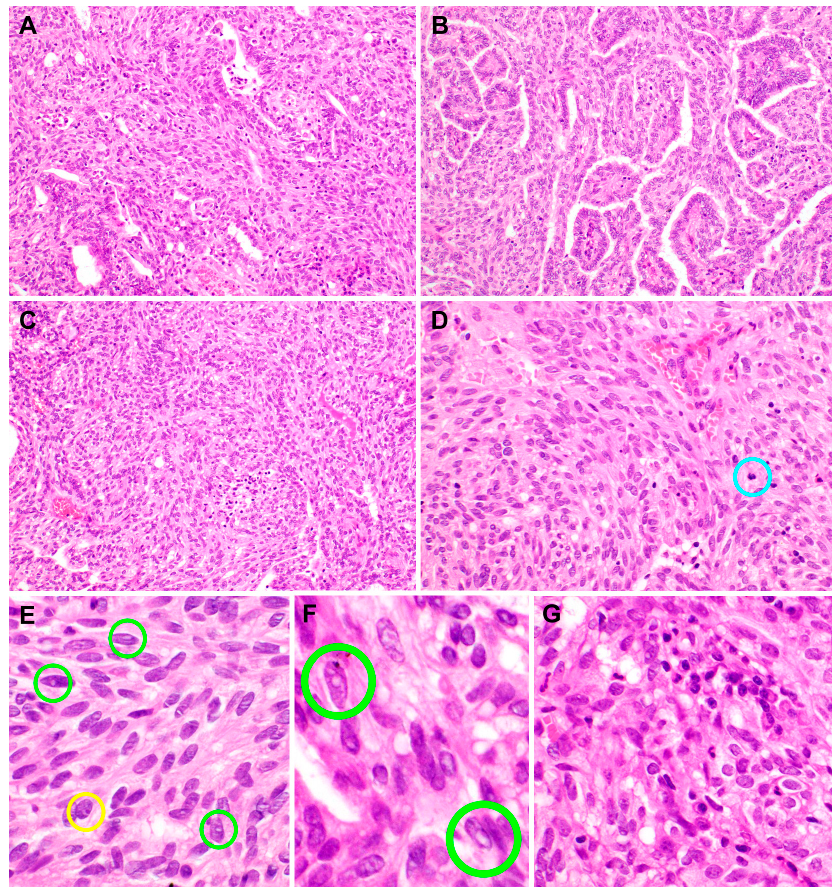
Figure 3. Histopathological features of the spindle cell component of the biphasic thyroid-like low-grade nasopharyngeal papillary adenocarcinoma. ( A ) Anastomosing nests and sheets of tumor cells with spindle-shaped nuclei were intermingled with the papillary component. ( B ) The papillary and spindle cell components merged imperceptibly. ( C ) In some areas, a transition from cuboidal-to-columnar tumor cells to spindle cells was observed. ( D ) Spindle cells were arranged predominantly in a stratified and whorling pattern. The blue circle indicates a mitotic figure. ( E ) Spindle cell nuclei were more elongated and hyperchromatic than the nuclei of epithelial cells covering the papillae. Small intranuclear pseudoinclusions (green circles), prominent nucleoli touching the nuclear membrane (yellow circle), and irregular nuclear membranes were observed. ( F ) High-power magnification view of the nuclear morphology; green circles indicate those resembling papillary thyroid carcinoma. ( G ) Some foci showed intratumoral inflammatory infiltrates. Hematoxylin and eosin stain. Original magnification: A to D, 100 × ; E,2060 × ; F, 400 × ; G, 200 ×